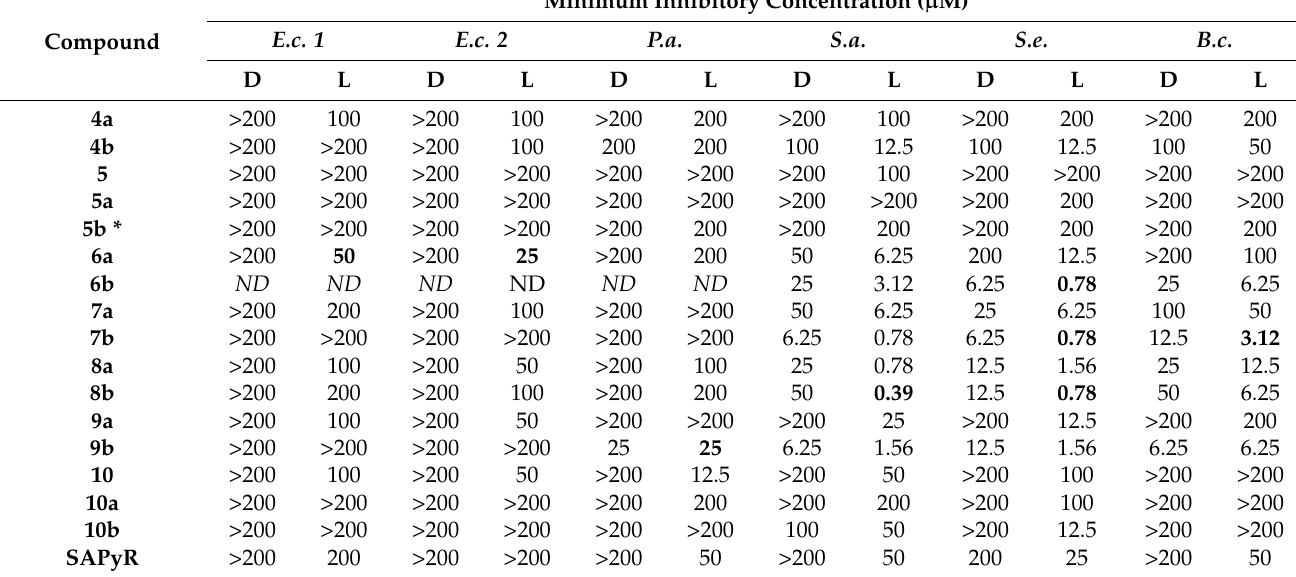
Table 2. Minimum Inhibitory Concentration of 17 phenalenone derivatives tested against 6 bacterial strains (E.c. 1: Escherichia coli CIP54.8T, E.c. 2: Escherichia coli CIP53.126, S.a.: Staphylococcus aureus CIP76.25, S.e.: Staphylococcus epidermidis CIP109.562, B.c.: Bacillus cereus CH, P.a.: Pseudomonas aeruginosa CIP76.110) under dark (D) and light (L)